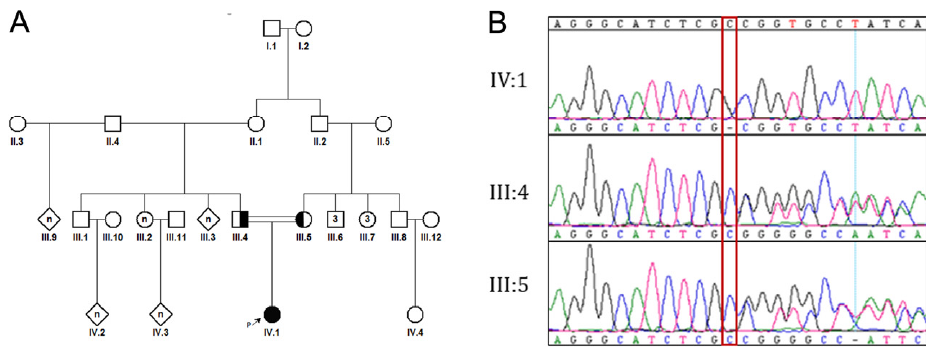
Figure 1. Genetic Analysis. ( A ) Pedigree of the family 1 showing the carrier parents, the affected girl and the consanguineous marriage. The affected girl is labeled with a filled symbol (black colored). The carrier parents are displayed with half-filled symbols. Squares indicates male individuals, whereas circles show females. ( B ) Sanger sequencing results of the variant are shown in chromatograms. The red box shows the deletion in IV:1.